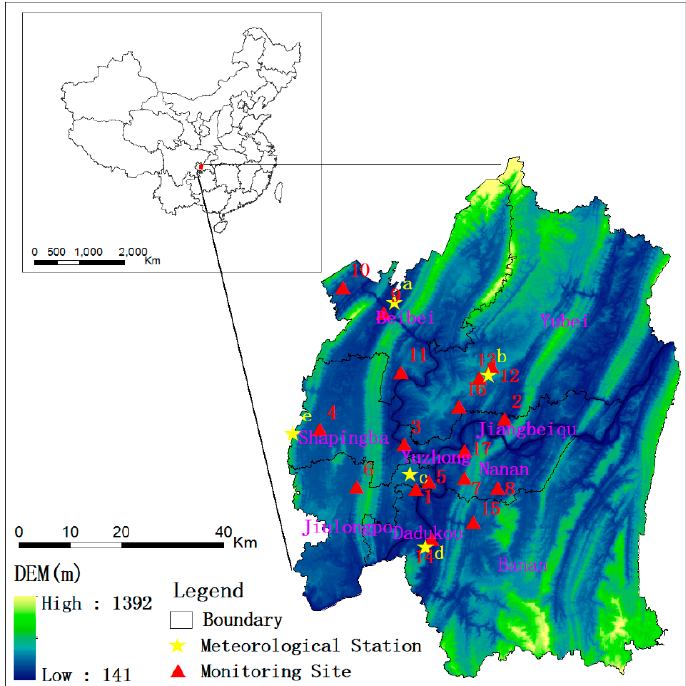
Figure 1. Study area and Locations of the 17 environment monitoring sites denoted by numbers (1. Xinshancun; 2. Tangjiatuo; 3. Gaojia; 4. Huxi; 5. Panjiaping; 6. Baishiyi; 7. Nanping; 8. Caiyuan; 9. Tiansheng; 10. Jinyunshan; 11. Caijia; 12. Lianglu; 13. Konggang; 14. Yuxinjie; 15. Nanquan; 16. Lijia; and 17. Jiefangbei), and 5 meteorology stations (a. Beibei; b. Jiangbei; c. Chongqing; d. Baxian; e. Bishan).